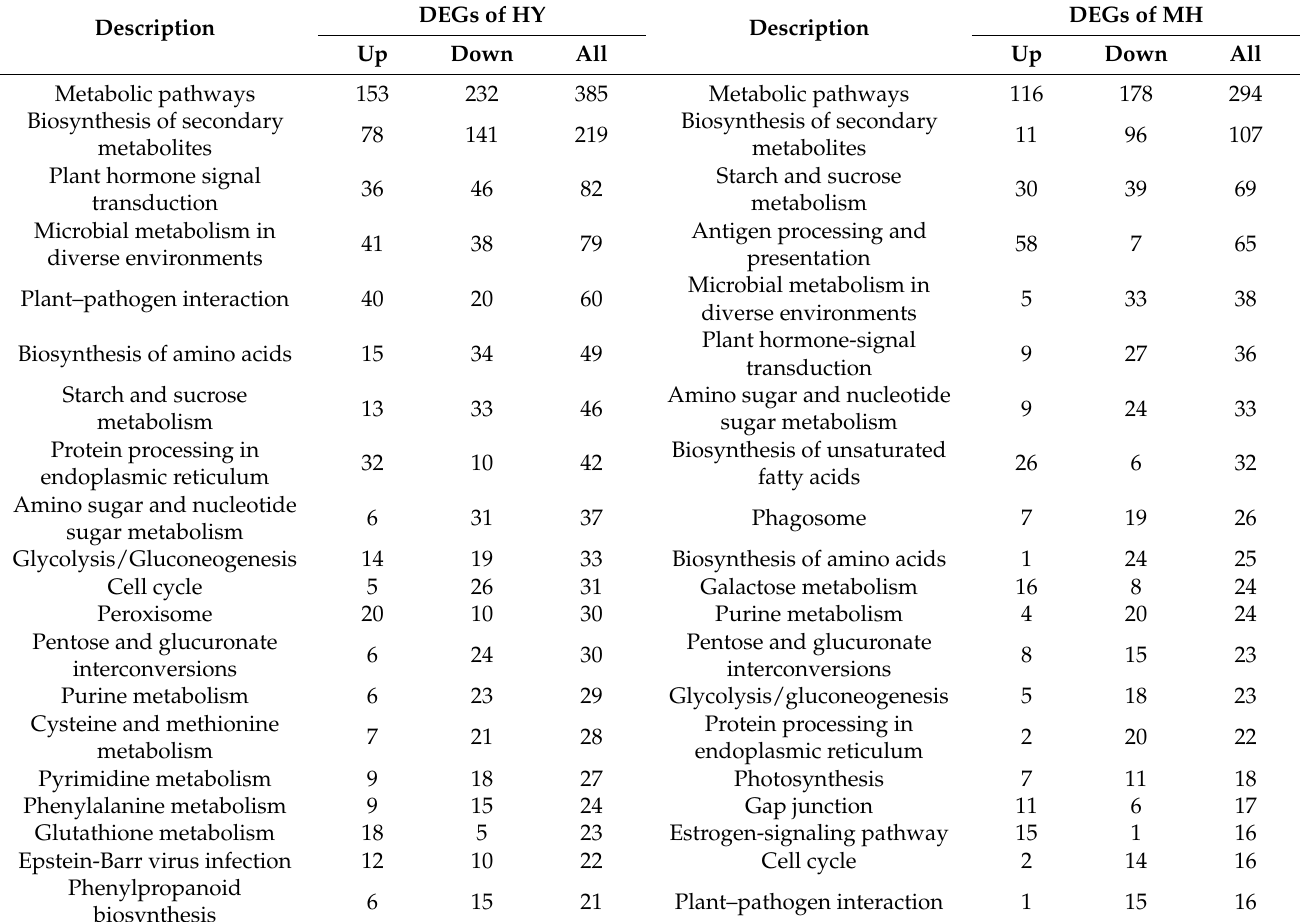
Table 2. The top 20 enriched pathways involved in secondary